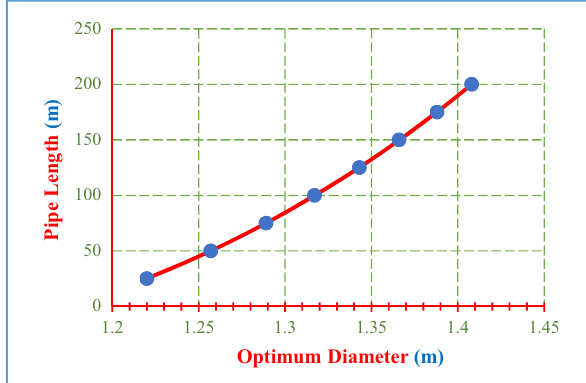
Figure 5: Optimum diameter vs pipe length.